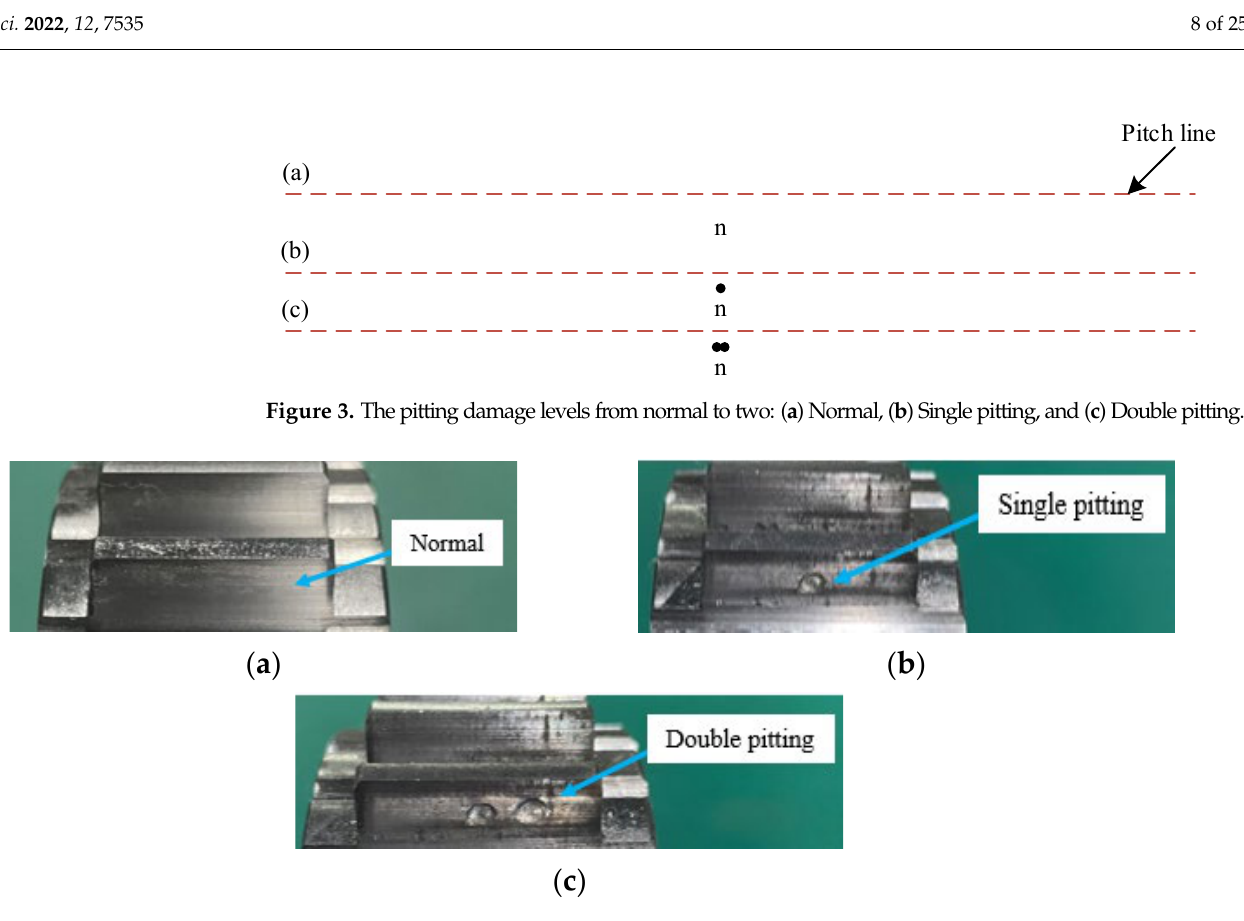
Figure 4. Pitting damage levels of the gears: ( a ) Normal condition, ( b ) Single pitting condition, and ( c ) Double pitting condition.